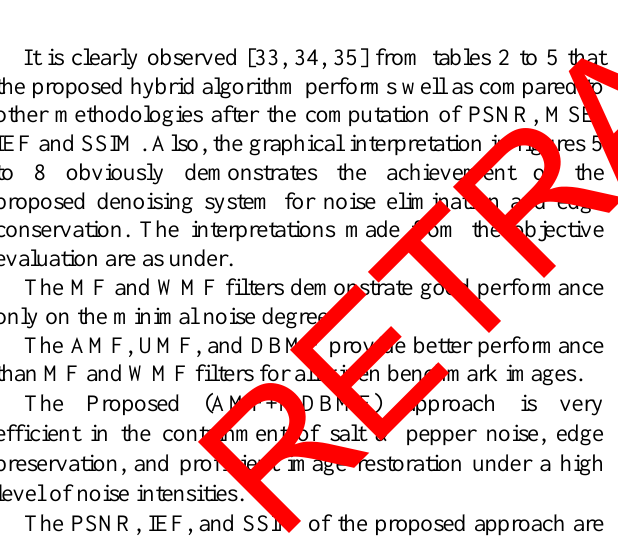
Figure 8. Comparison of SSIM values on different